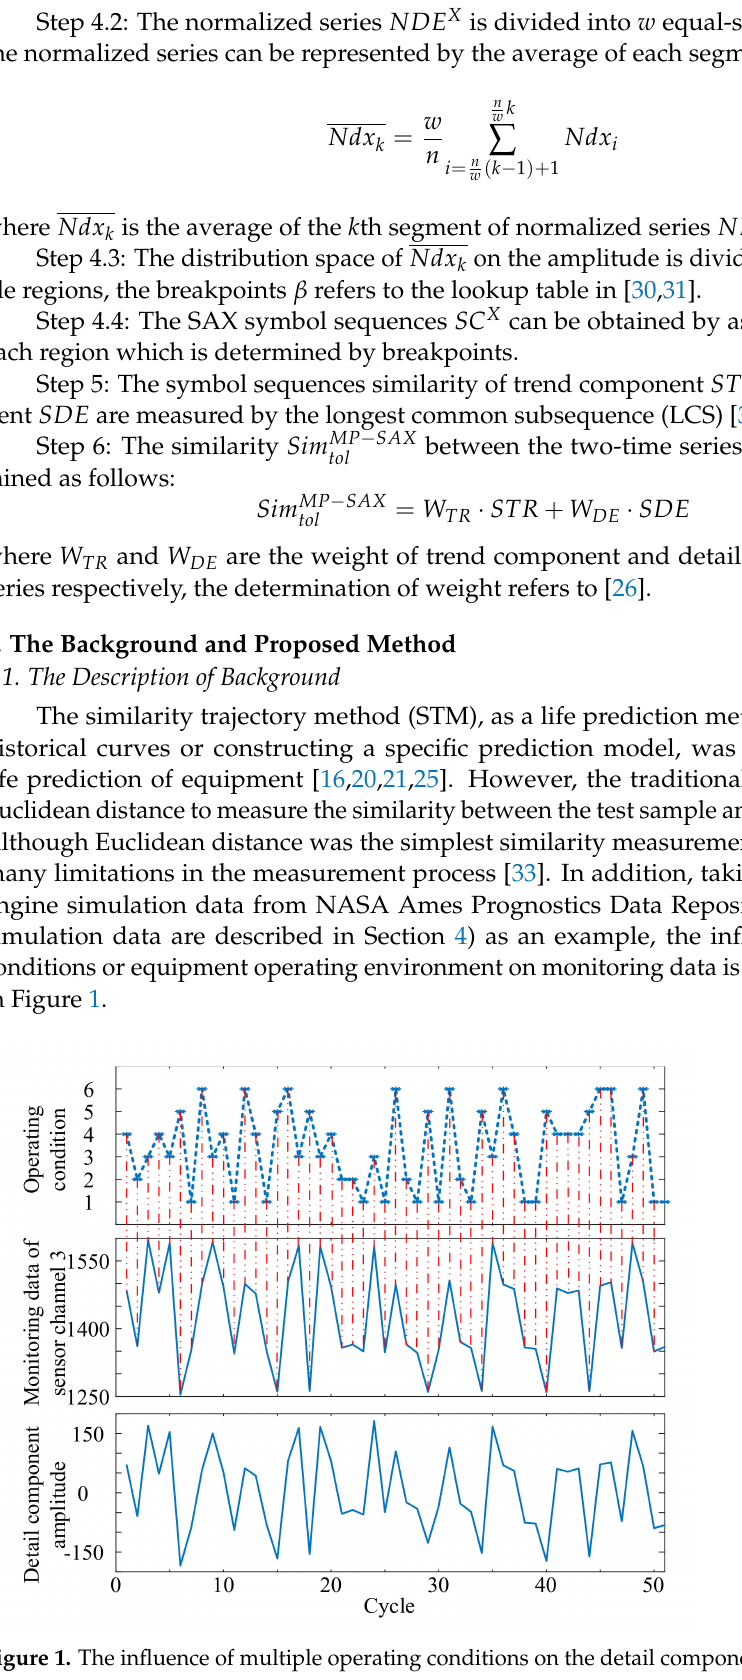
Figure 1. The influence of multiple operating conditions on the detail component of monitoring